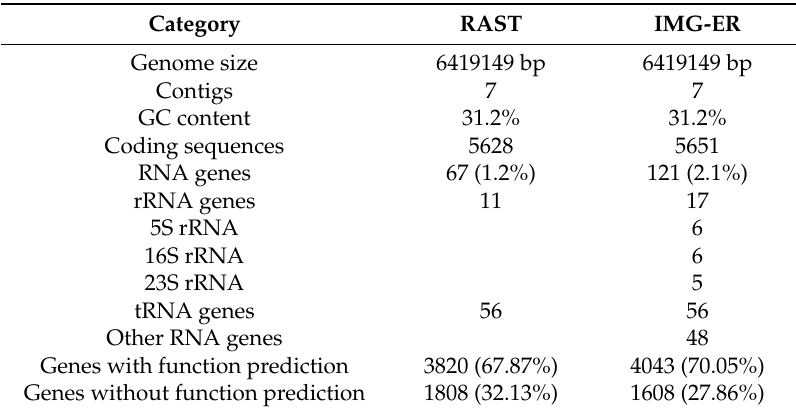
Table 1. General genome